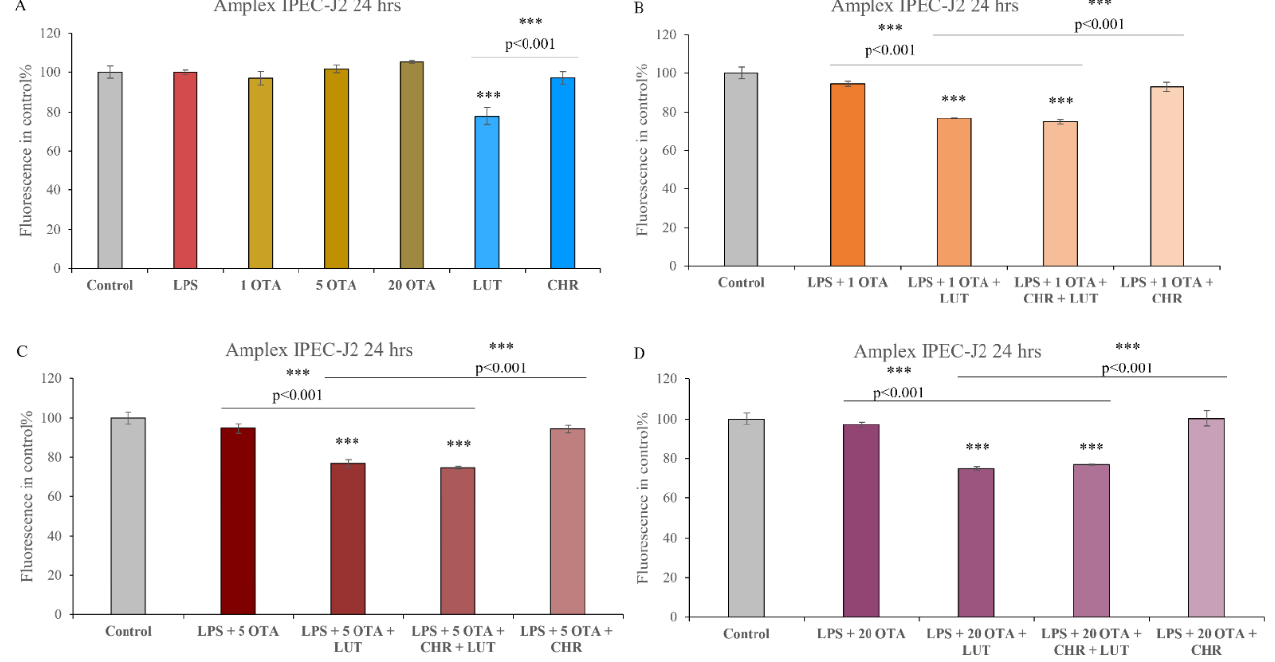
Figure 4. Relative fluorescence intensity in control% using Amplex red method. Changes in fluorescence intensities can be seen after 24 hrs of the combined treatment of cells with 1 µM OTA, 5 µM OTA, 20 µM OTA, 1 µM CHR, 8.7 µM LUT, 10 µg/mL LPS ( A – D ); data are shown as a means of relative fluorescence intensities with SEM; n = 4 samples per group; *** indicates p < 0.001, λ exc = 530 nm, λ em = 590 nm. Asterisks alone indicate significant differences between control and treated groups, asterisks with p values underlined show significant changes between the designated groups.